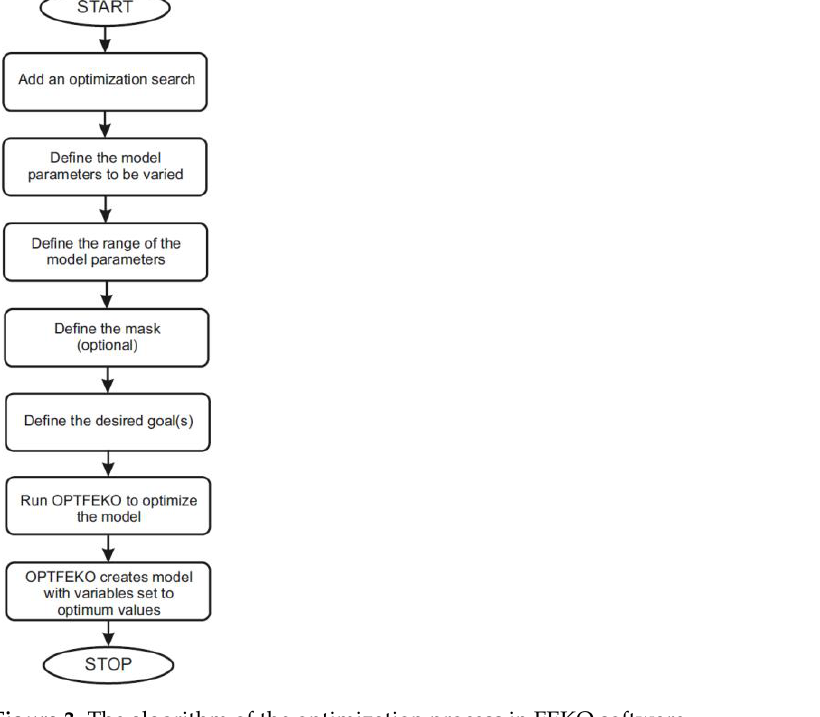
Figure 3. The algorithm of the optimization process in FEKO software. During the optimization process, one of the following optimization methods of FEKO software must be chosen: simplex (Nelder–Mead), particle swarm optimization (PSO), or genetic algorithm (GA). For the above methods, there are two options for stop criteria: Specify maximum number of runs by the solver: The optimization process